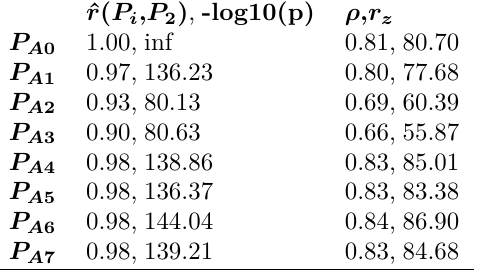
Table 5: Comparison among several profiling